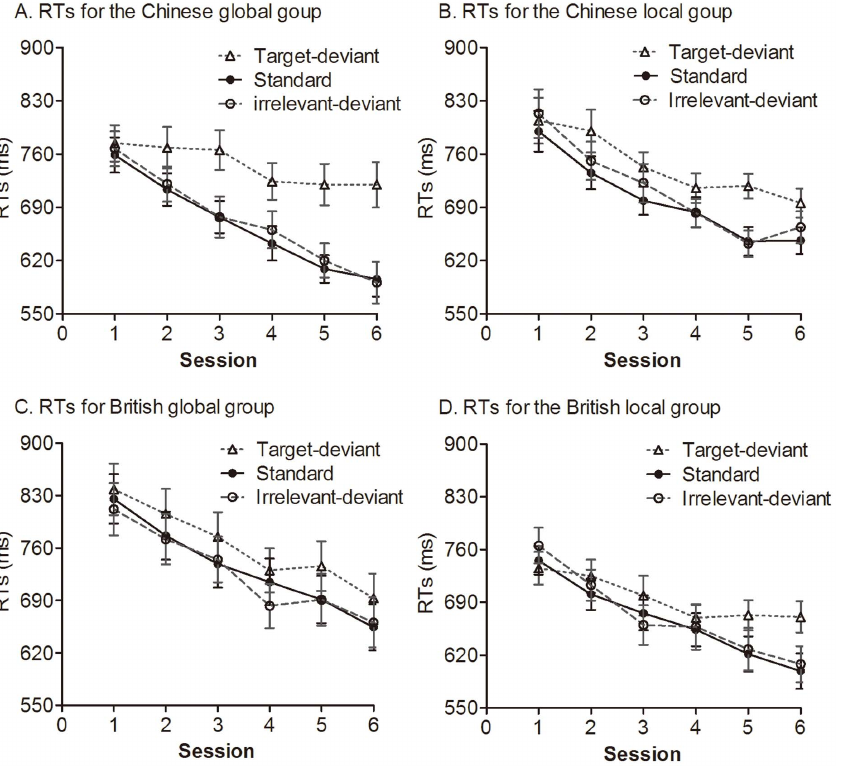
Figure 3. Mean reaction times (RTs) for target-deviant, standard, and irrelevant-deviant stimuli across training blocks in each group. Error bars depict standard errors.